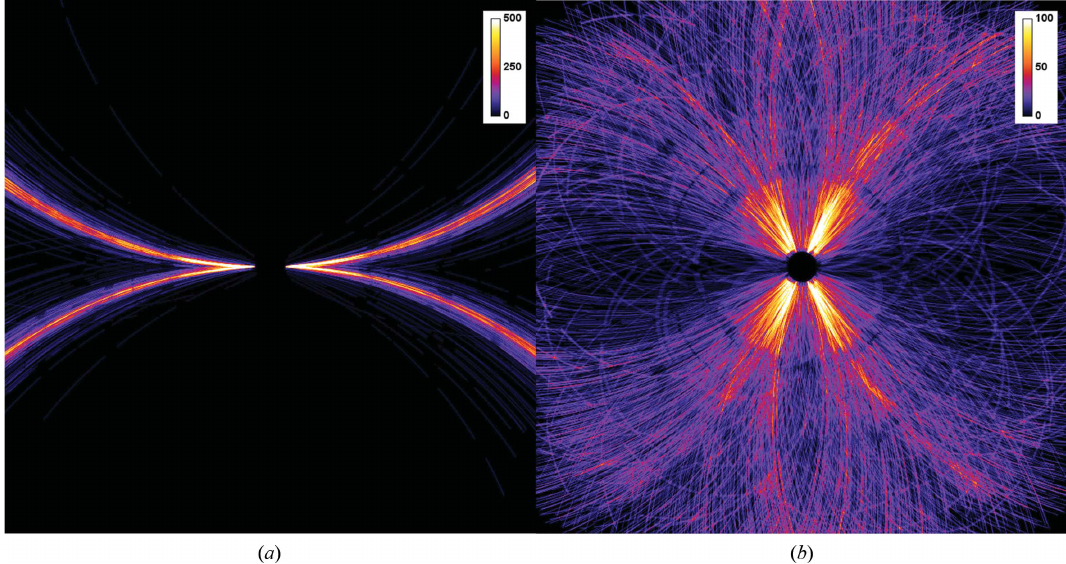
Figure 9 Accumulated Bragg spots of 3000 patterns collected from hAQP2 crystals with the silicon chip oriented perpendicular to the beam ( a ) and at a tilt angle of 25 (cid:6) ( b ). The preferred orientation of the crystals lying on the silicon-chip surface leads to poor coverage of reciprocal space. In order to obtain a more complete data set, the chip has to be tilted during data collection. The color code of the scale bars indicates the number of patterns that contribute to each pixel in merged reciprocal space.